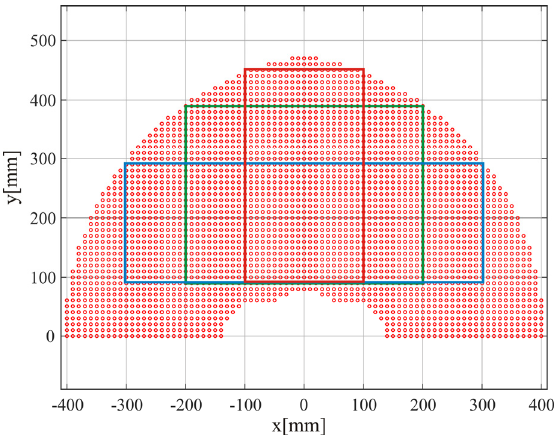
Figure 5. Workspace of considered robot For the application of robot tasks, the operators could use all portions of the workspace with irregular shapes or reduced workspace to appropriate paral– lelepiped according to tasks, Fig. 5.